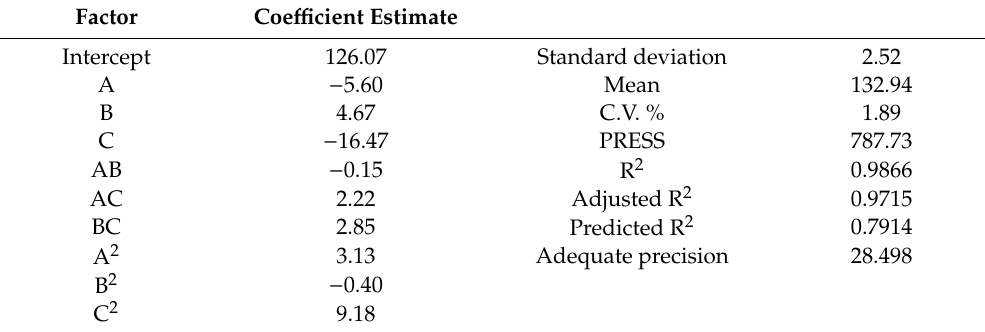
Table 4. Regression coe ffi cient estimate results for the e ff ect of the three variables.